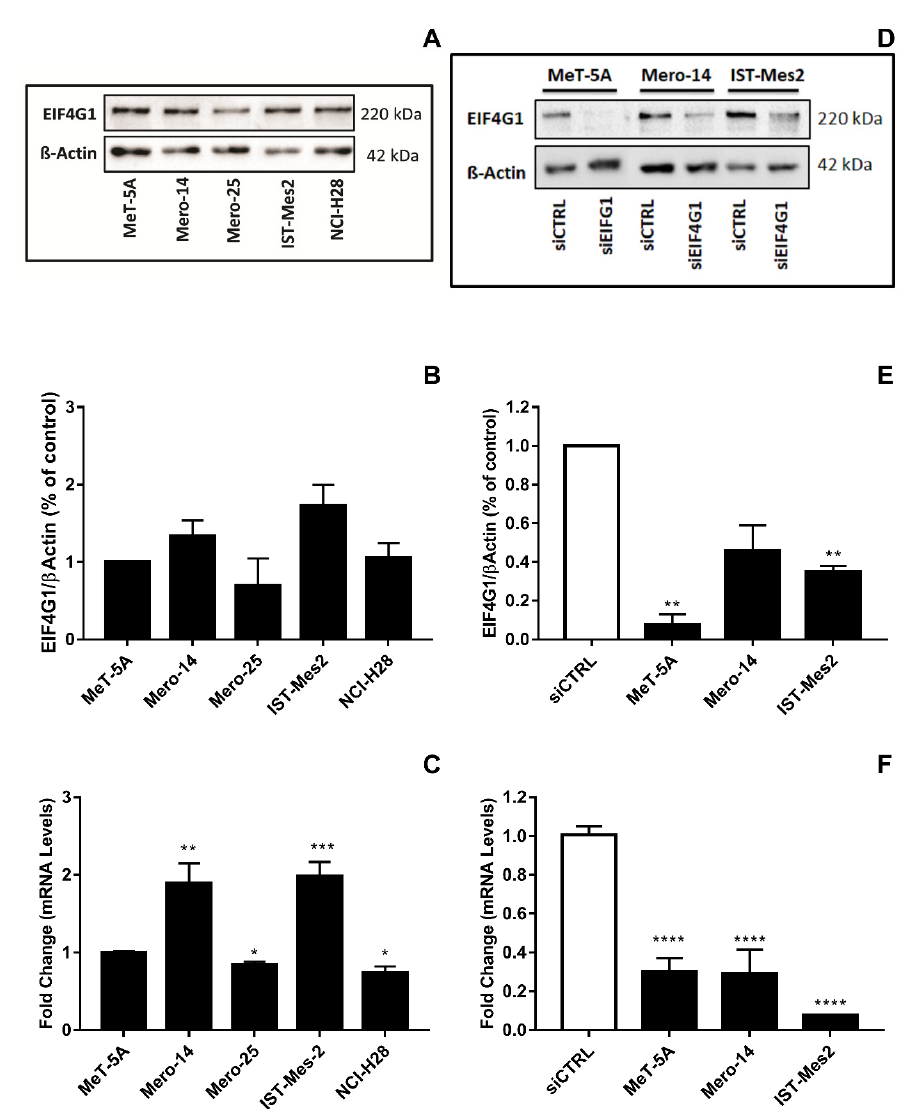
Figure 1. Expression of EIF4G1 in non-malignant MeT-5A and a panel of malignant pleural mesothelioma (MPM) cells, as Mero-14, Mero-25, IST-Mes2, and NCI-H28. ( A ) : Picture representing basal protein levels of EIF4G1. β -Actin was used as reference. The present picture is representative of one of two experiments performed. ( B ) : Histogram reporting protein levels of EIF4G1, normalized to β -actin. The histogram was generated by quantifying blots from two independent experiments and normalizing the intensity of the bands to the MeT-5A lane. ( C ) : RT-qPCR showing fold changes of mRNA basal levels of EIF4G1 gene, measured in MPM cell lines and related to MeT-5A, set to one. RPLP0 , HPRT1 , and TPB were used for normalization. ( D ) : Picture representing protein levels of EIF4G1 after its depletion through siEIF4G1-1. β -Actin was used as reference. The present picture is